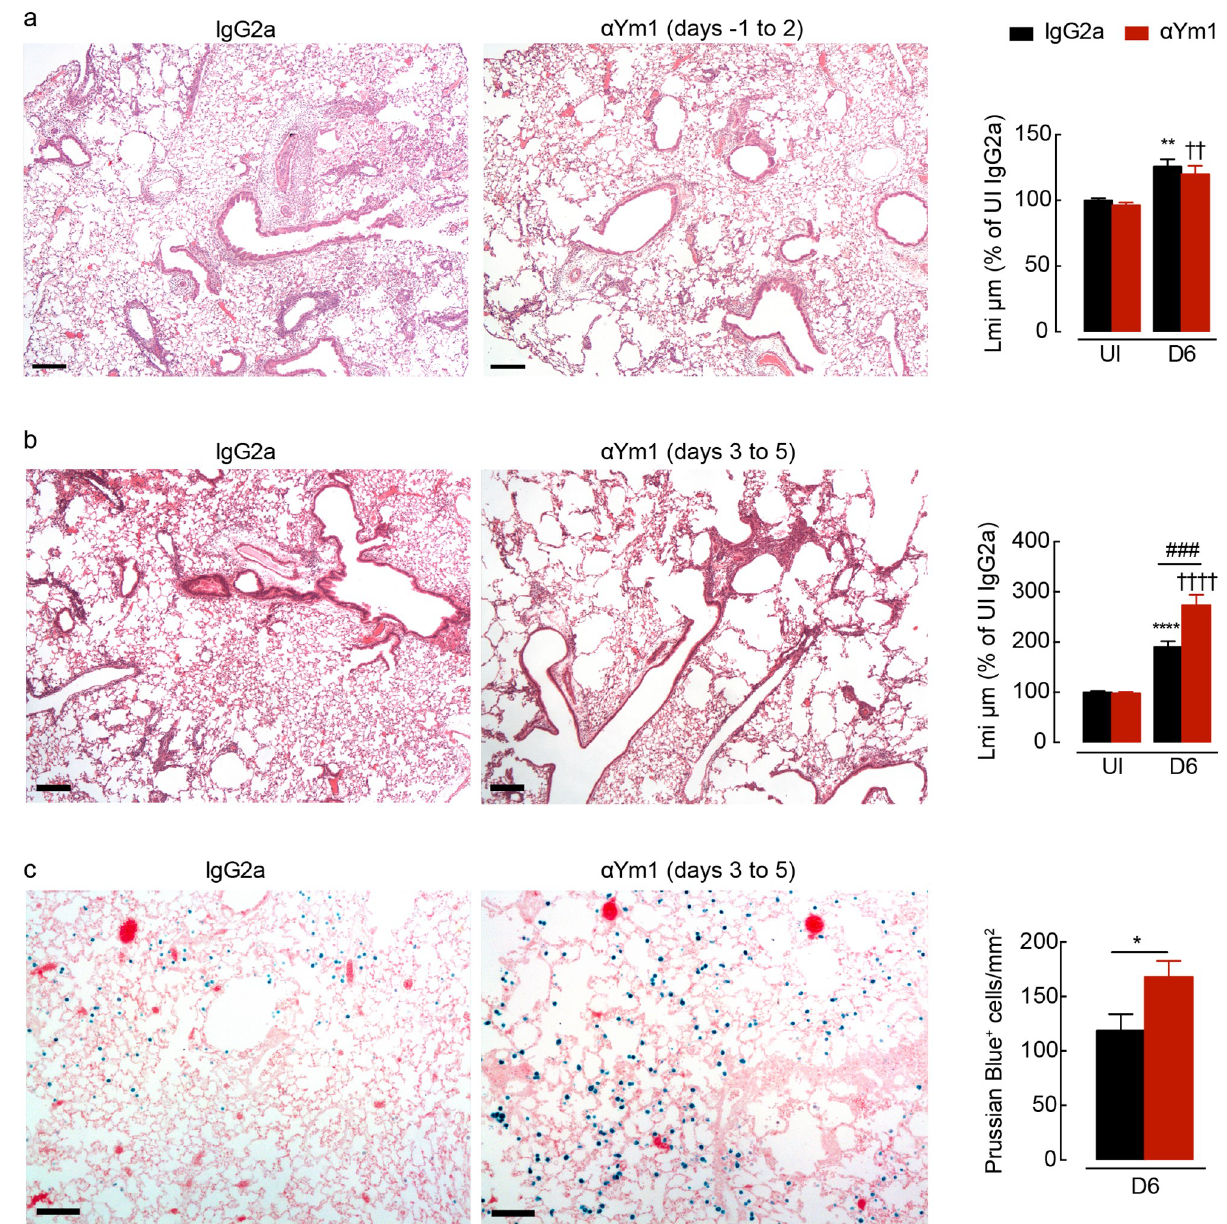
Fig 4. Adaptive Ym1 is required for rapid repair of the lung following helminth infection. (a) Microscopy of lung sections from mice uninfected or N . brasiliensis (500 L3’s) infected mice (day 0) treated intraperitoneally with anti-Ym1 or IgG2a (days -1 to +2) and collected at day 6, stained with hematoxylin and eosin (images are representative of n = 6, scale bars, 200 μ m; graph shows quantification of lung damage as linear means intercept (Lmi), data normalised to average Lmi in uninfected IgG2a treated mice, n = 6 per group; data are shown as mean ± sem; two-way ANOVA with Sidak multi-comparison test; �� P < 0.01 compared to UI IgG2a treated; ✝✝ P < 0.01 compared to UI anti-Ym1; data representative of 2 independent experiments). ( b ) Microscopy of lung sections from mice uninfected or N . brasiliensis infected mice (day 0) treated intraperitoneally with anti-Ym1 or IgG2a (days 3 to 5) and collected at day 6, stained with hematoxylin and eosin (images are representative of n = 6, scale bars, 200 μ m; graph shows quantification of lung damage as linear means intercept (Lmi), data normalised to average Lmi in uninfected IgG2a treated mice, n = 6 per group; data are shown as mean ± sem; two-way ANOVA with Sidak multi-comparison test; ���� P < 0.0001 compared to UI IgG2a treated; ✝✝✝✝ P < 0.0001 compared to UI anti-Ym1; ###P < 0.001 IgG2a infected compared to anti-Ym1 infected mice; data representative of 3 independent experiments). (c) Microscopy of lung sections from mice as in b , stained with prussian blue. Graph shows quantification of the number of prussian blue positive cells per area of lung. (images are representative of n = 6, scale bars, 100 μ m, n = 6 per group; data are shown as mean ± sem; unpaired t test, � P < 0.05; data representative of 3 independent experiments).